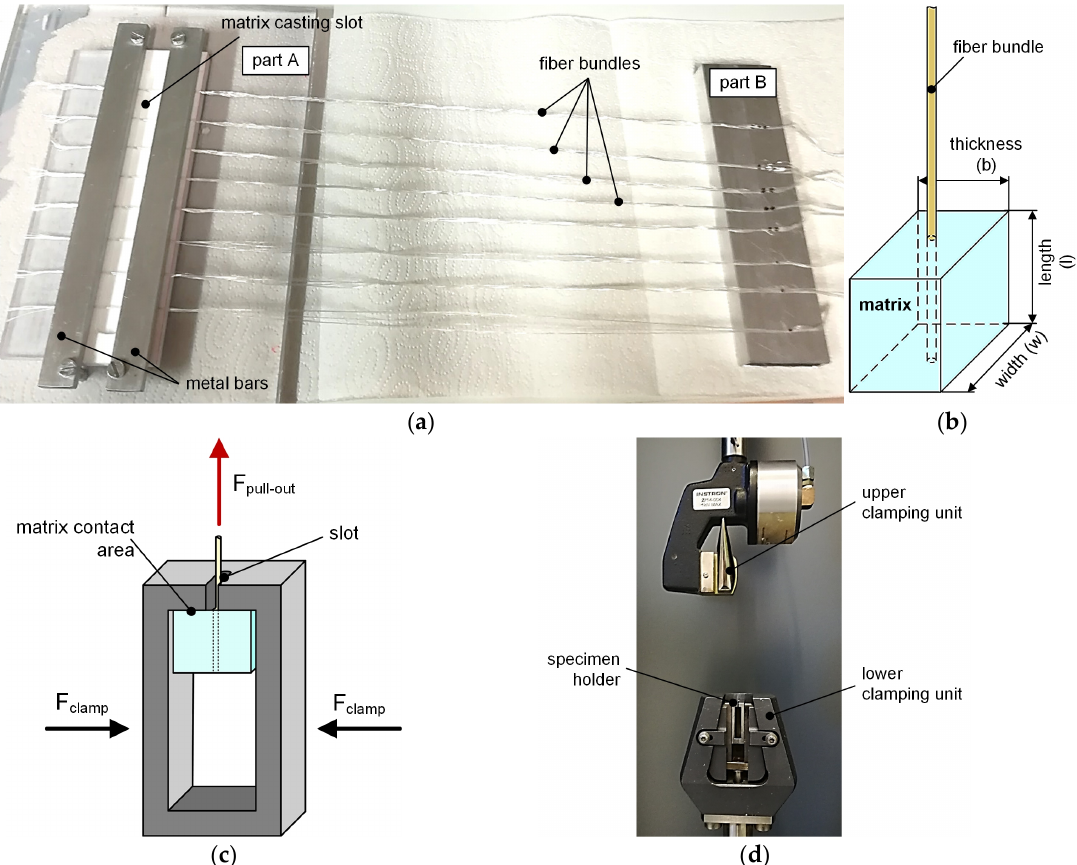
Figure 1. Manufacturing tool including main components ( a ) with specimen ( b ) and schematical test procedure with the modified specimen holder ( c ) with test setup for FBPO test ( d ).